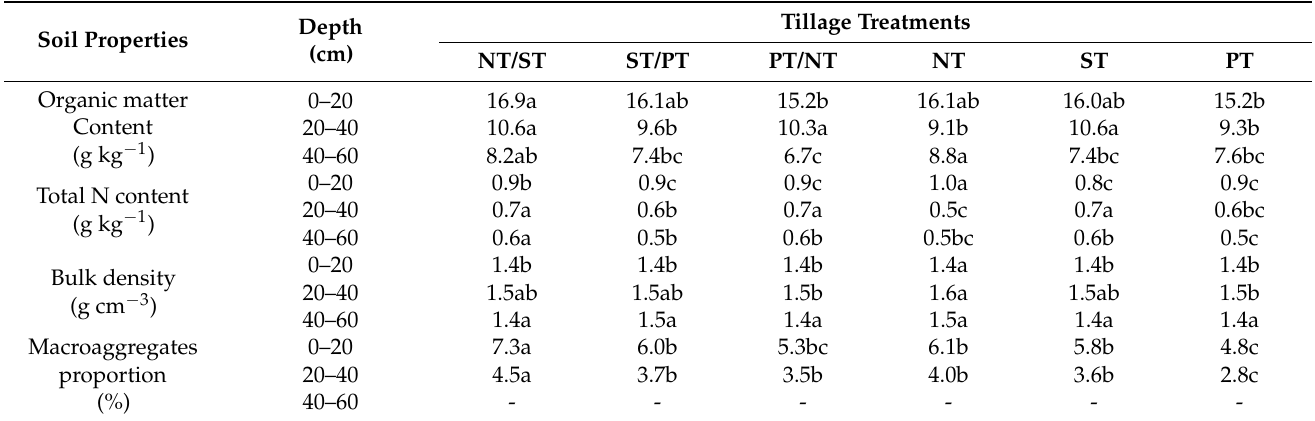
Table 2. Soil property after 8 years of tillage treatment at depths of 0–20